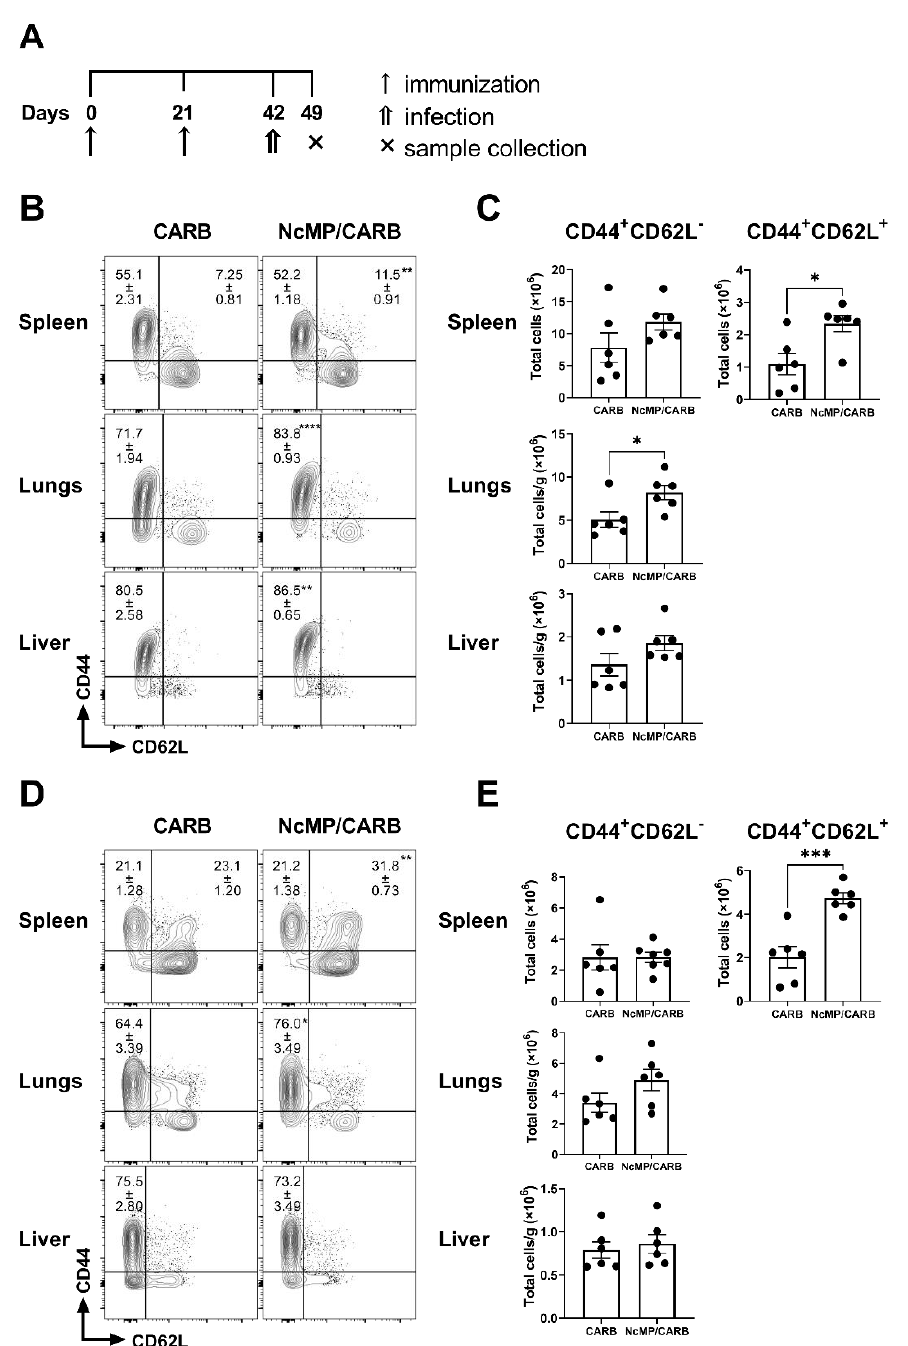
Figure 6. Memory phenotype of CD4 + and CD8 + T cells in infected mice. Timeline of immunization, infection and sample collection ( A ). Representative contour plot analysis of gated CD4 + ( B ) and CD8 + ( D ) T cells expressing CD44 and CD62L in the indicated organs. Numbers within contour plots correspond to mean percentage values ± SEM for the particular quadrant region in the respective sham-immunized (CARB) or immunized (NcMP/CARB) groups, as indicated. Numbers of CD4 + ( C ) and CD8 + ( E ) T cells presenting the cell surface phenotypes CD44 + CD62L − and CD44 + CD62L + , as indicated, in the analyzed organs of CARB and NcMP/CARB groups, 7 days upon N. caninum i.p. infection. In panels ( C , E ), bars represent means ± SEM. Each symbol (black circle) represents an individual mouse. Results are from one experiment representative of two independent experiments that yielded concordant results ( n = 6 group; * p < 0.05; ** p < 0.01; *** p < 0.001; **** p < 0.0001, unpaired t -test).